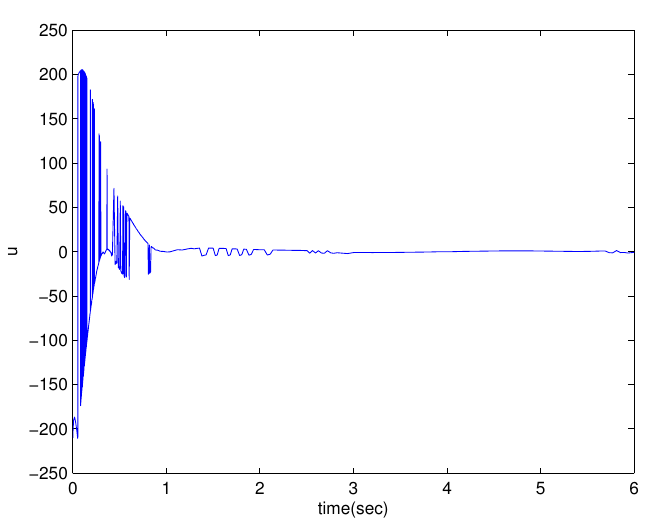
Figure 9. The control input evolution curve.